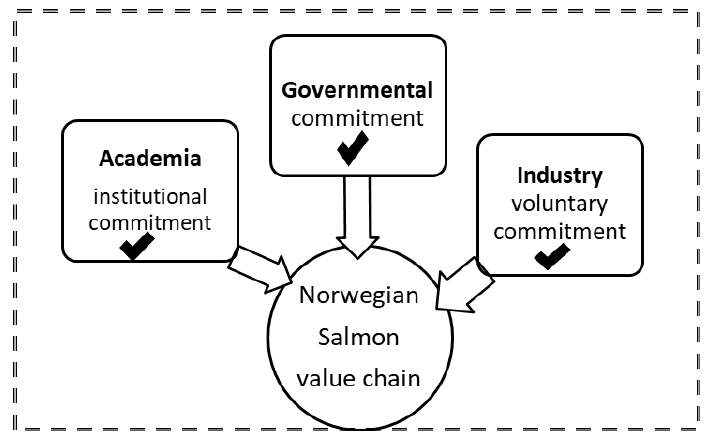
Figure 4. Stakeholders’ commitment to SDGs.